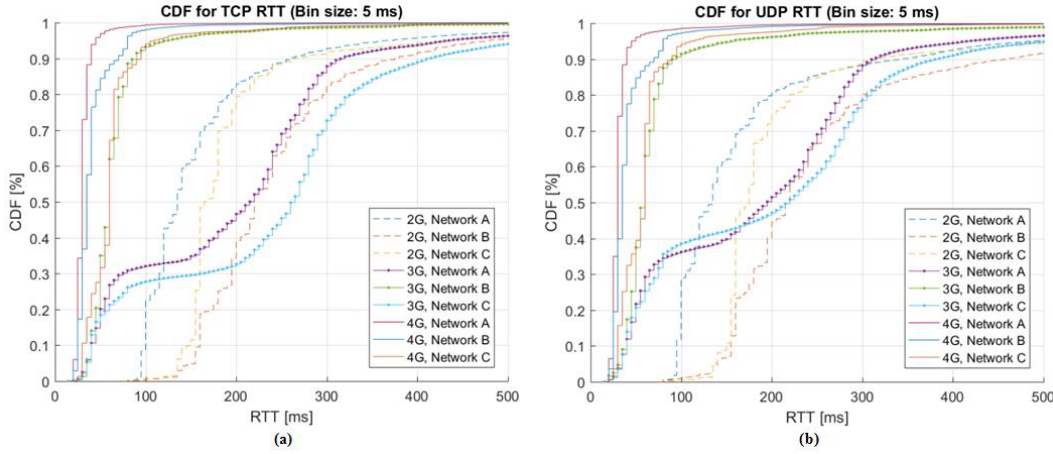
Figure 14. Comparison of ( a ) f Nadir and ( b ) T Nadir obtained in Test Scenario -2 with that of Reference Frequency Response at 95% Confidence